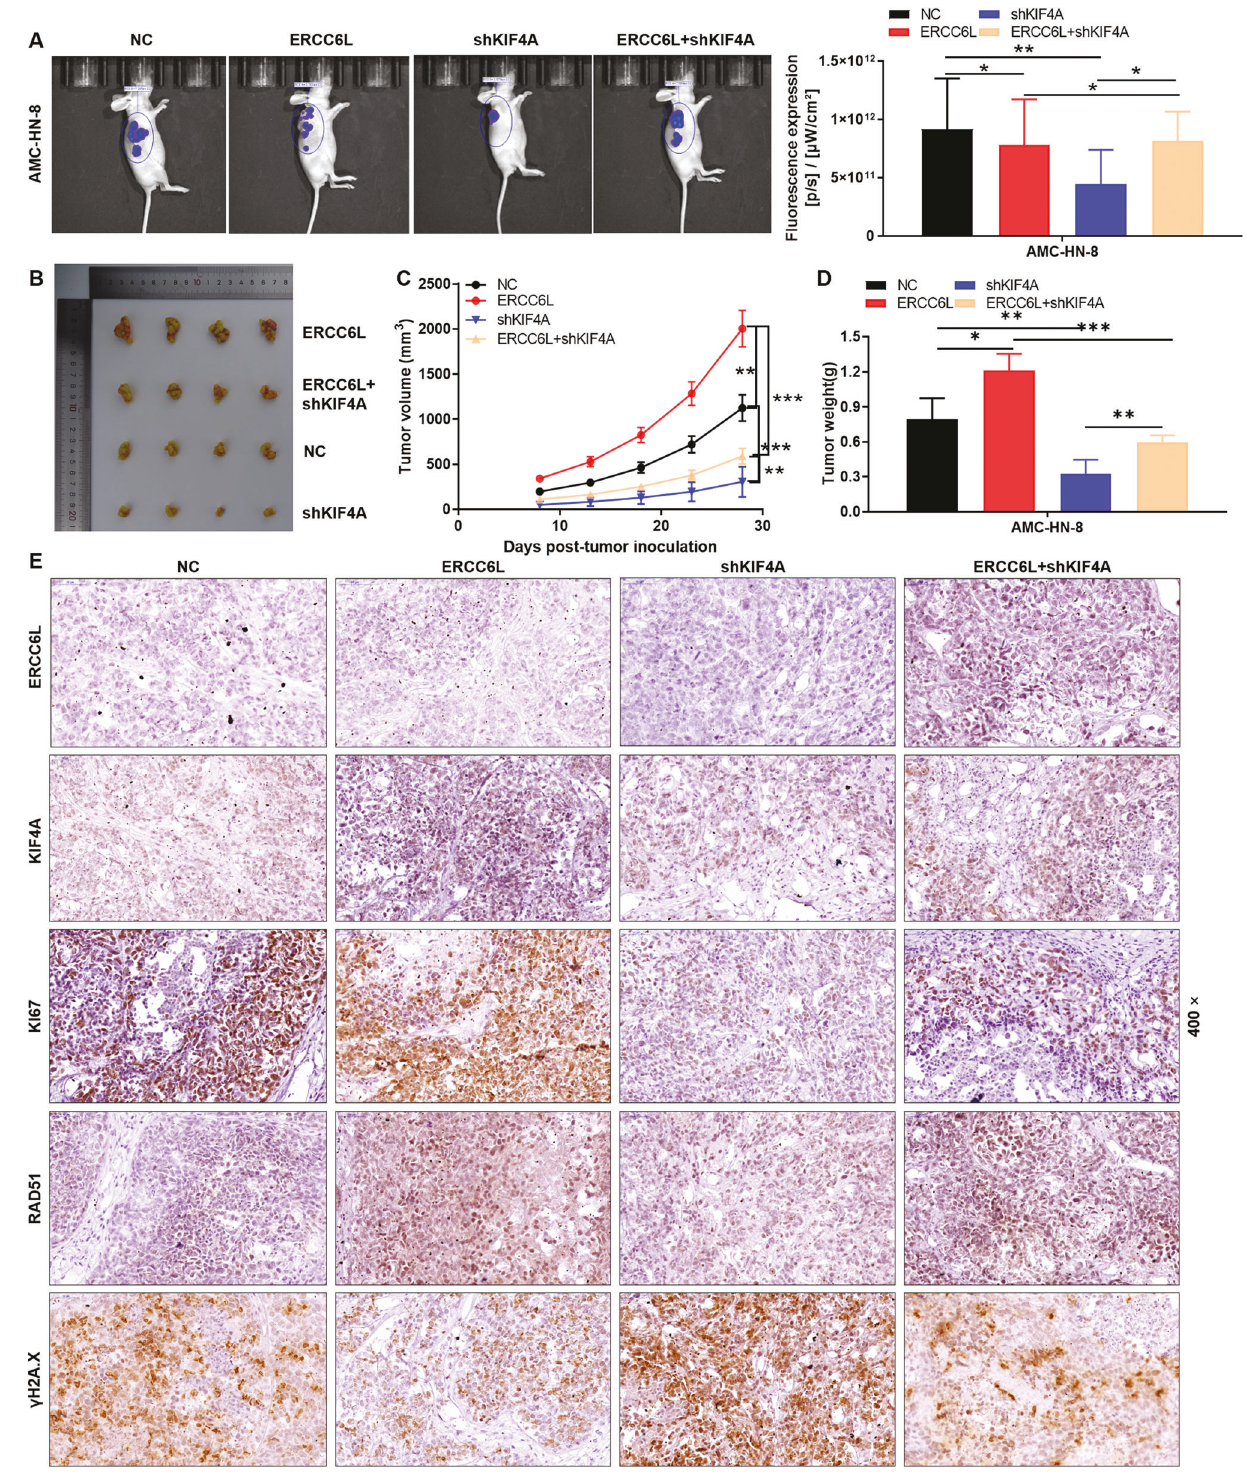
Fig. 5 KIF4A knockdown attenuates the role of ERCC6L overexpression in promoting tumorigenesis of LSCC cells. A In vivo imaging was performed to evaluate the tumor burden in mice of NC, ERCC6L, shKIF4A, and ERCC6L + shKIF4A groups post tumor-inoculation. B – D Mice were monitored for 28 days and data were collected on the volume and weight of the xenografts. E IHC staining was performed to determine the expression of ERCC6L, KIF4A, Ki67, RAD51, and γ H2A.X. Data was shown as mean ± SD ( n = 4). * P < 0.05, ** P < 0.01, *** P < 0.001. re fl ected by 2 − △ Ct . The upstream and downstream primer sequences for 5 ′ -GTAAAGGCACAAGTCGTATCCA-3 ′ ; The upstream and downstream primer amplifying ERCC6L are shown below: 5 ′ -AAAAGTCAAGCAACCCAGAGG-3 ′ and sequences for amplifying KIF4A are shown below: 5 ′ - CTGCCAACAAGCGTCT